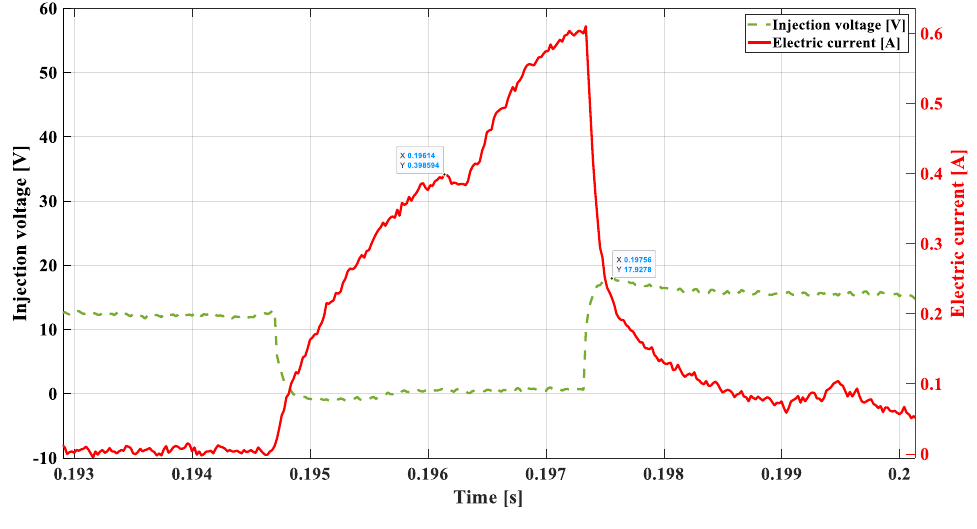
Figure 15. Short circuit using a 10 Ω resistor, 800 rpm.